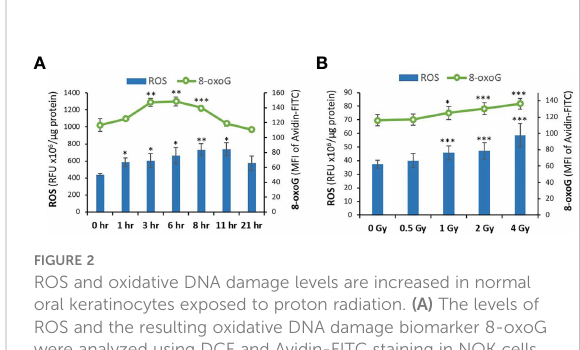
FIGURE 2 ROS and oxidative DNA damage levels are increased in normal oral keratinocytes exposed to proton radiation. (A) The levels of ROS and the resulting oxidative DNA damage biomarker 8-oxoG were analyzed using DCF and Avidin-FITC staining in NOK cells irradiated with 4 Gy of protons at different time-points (0, 1, 3, 6, 8, 11, 21 hr). (B) ROS and 8-oxoG were measured in NOK cells irradiated with different doses of proton radiation (0, 1, 2, 4 Gy) 6-8 hours after exposure. Asterisks on bars represent signi fi cance relative to the control group. (*), (**), and (***) correspond to p<0.05, 0.01, and 0.001,